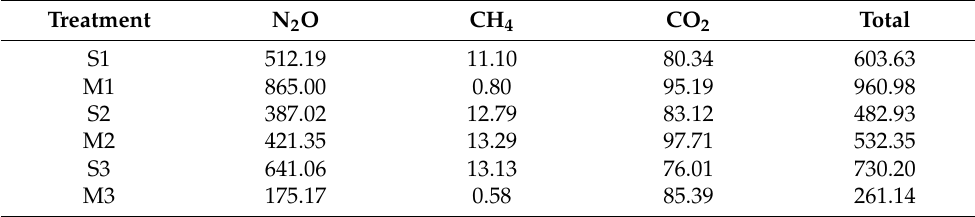
Table 2. Global warming potential of CO 2 , CH 4 , and N 2 O (kg · Mg − 1